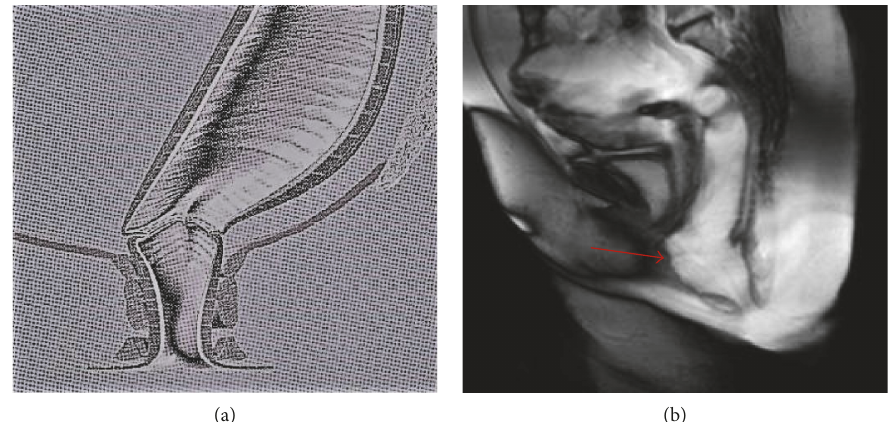
Figure 1: Result of STARR operation. Normal pattern: schematic drawing (a) and midsagittal BTFE pulse sequence MR image (b) taken during emptying of the intrarectal contrast; a minimal indentation is noted at the site of the anastomotic ring (arrow).